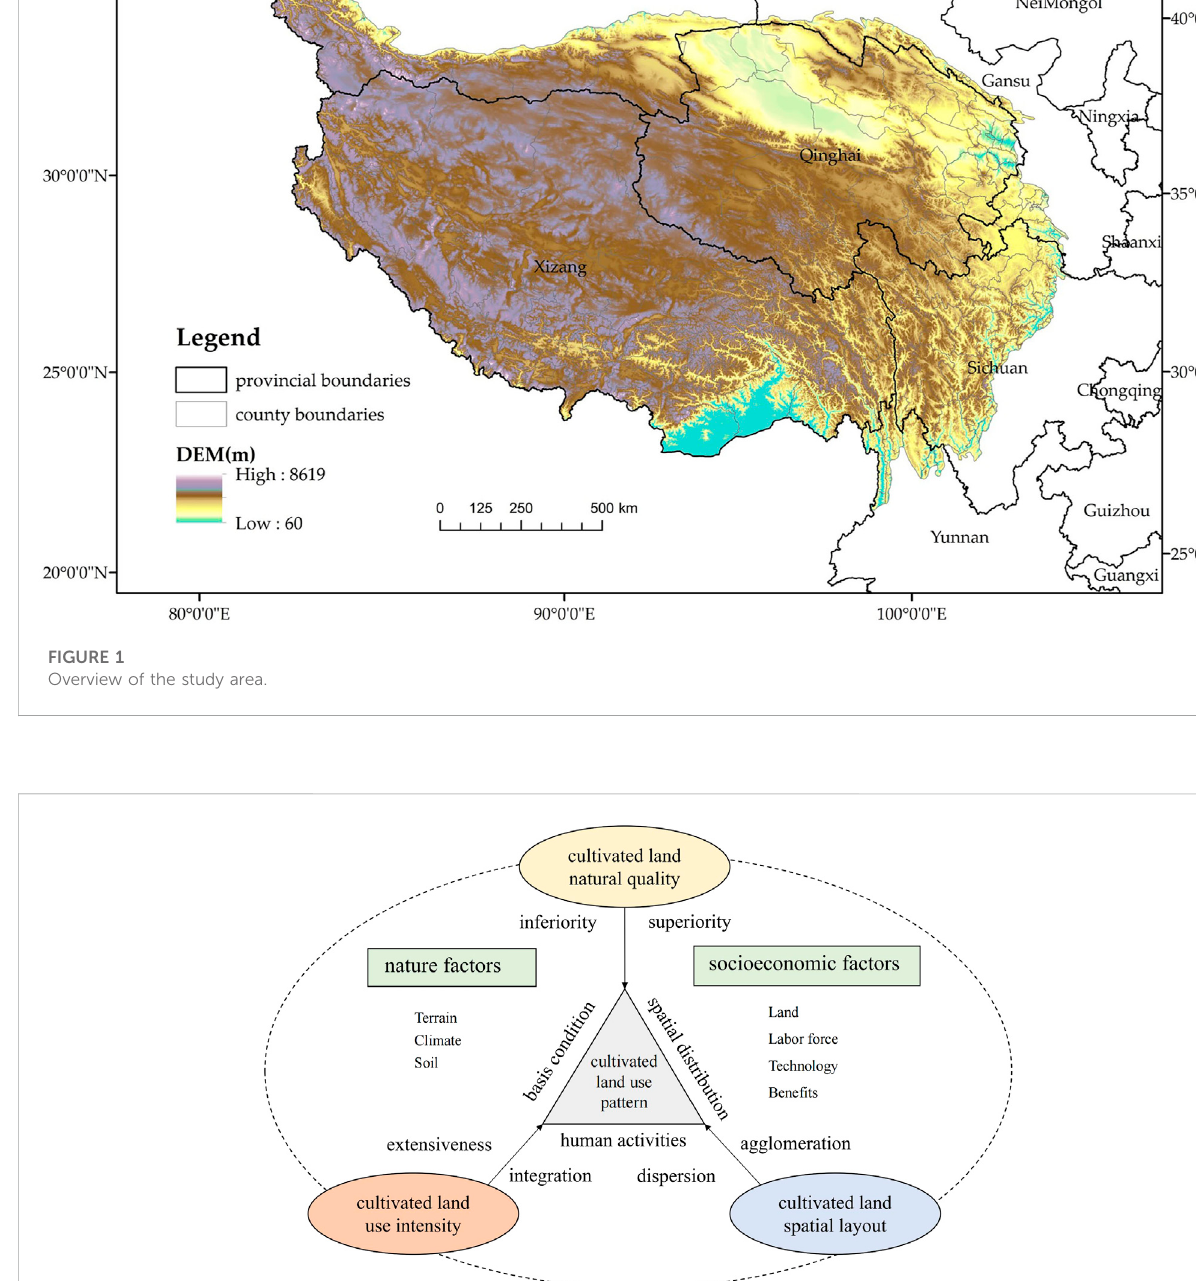
FIGURE 2 Research framework of cultivated land use